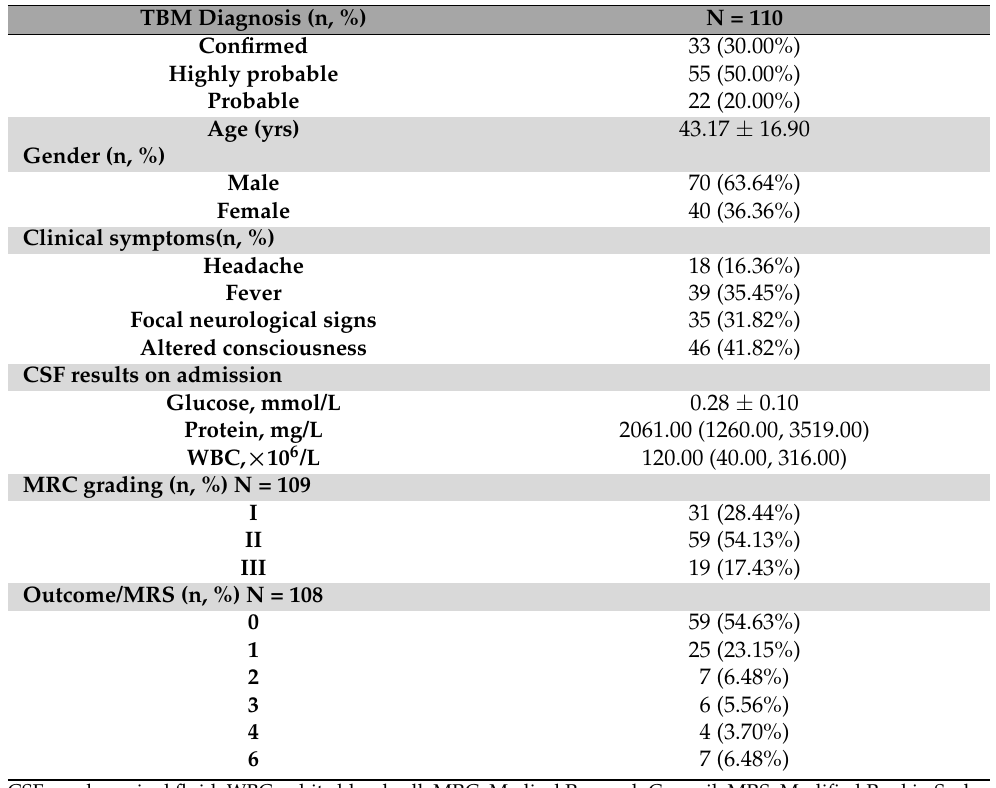
Table 2. Clinical characteristics of the study’s